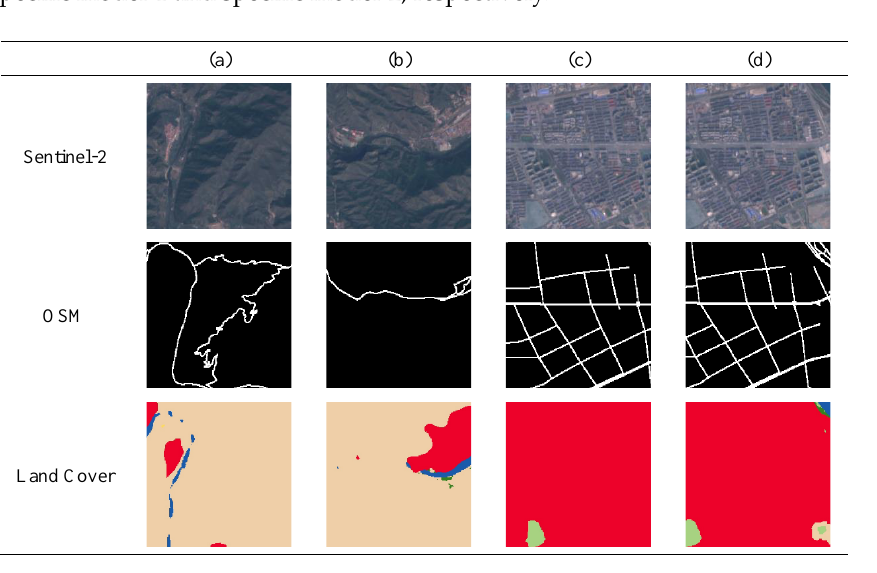
Figure 4. Examples of regions covered by Scrub/shrubs ( a , b ) and Built Area ( c , d ).